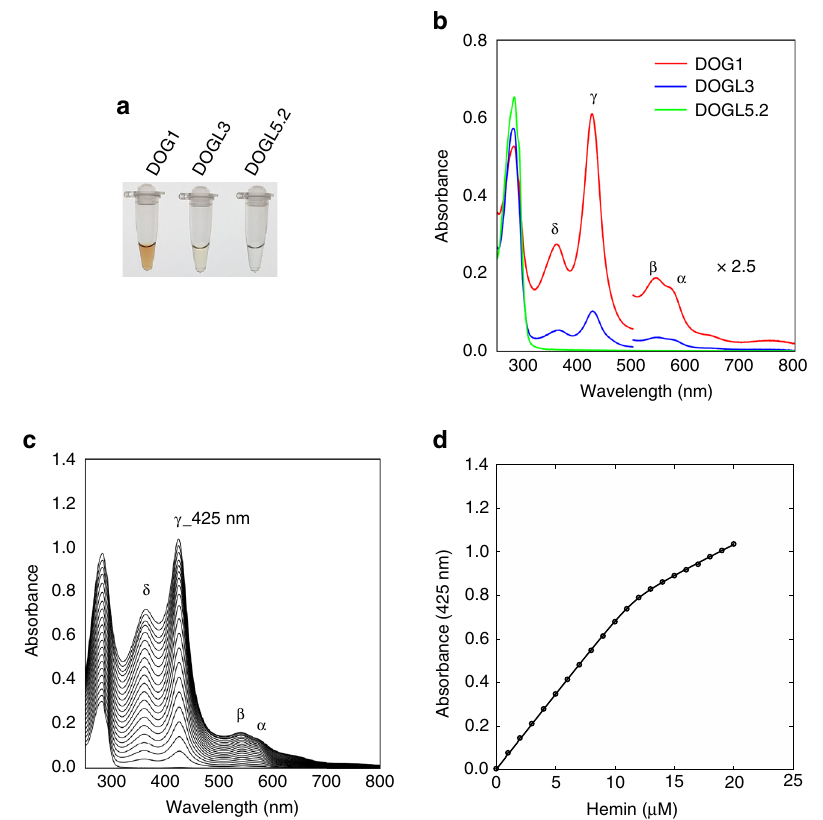
Fig. 7 Heme binding properties of DOG1. a E . coli expressed N-terminal His 6 -tagged DOG1 (29 μ M), DOGL3 (40 μ M), and DOGL5.2 (40 μ M) for 50-60 h in TB medium (condition II). b Electronic absorption spectra of the DOG1 (11 μ M), DOGL3 (15 μ M), and DOGL5.2 (15 μ M) shown in a . c Electronic absorption spectra of the untagged DOG1 (9.4 μ M) after the addition of hemin at the amount of up to ca. 2 mol equivalents of protein. d The γ (Soret) peak absorbance at 425 nm plotted as a function of hemin concentration. Nonlinear curve fi tting of experimental data as described in the Methods produced K d = 59 nM, ε = 79.4 mM − 1 cm − 1 , ε = 27.4 mM − 1 cm − 1 , and x = 0.81. ε ε fi cients of the DOG1-bound heme and the free DH H DH , and H are the extinction coef hemin at 425 nm, respectively, while “ x ” represents a fraction of the active hemin, which can be incorporated into